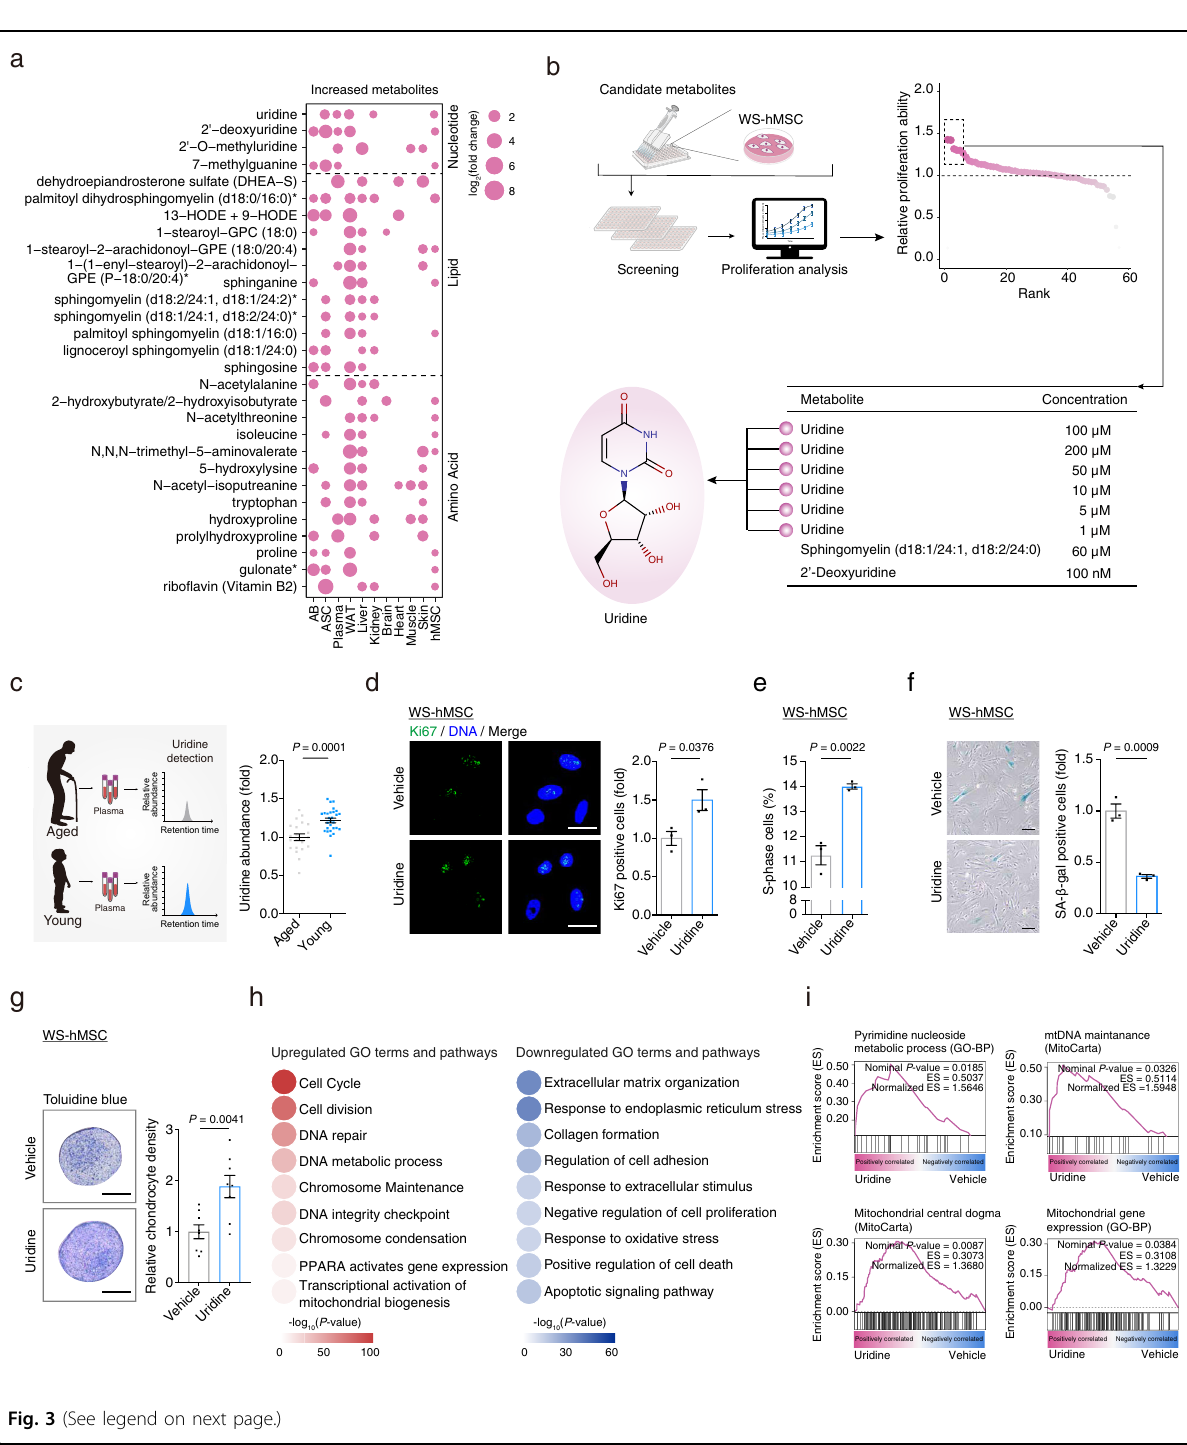
Uridineriboflavin (Vitamin